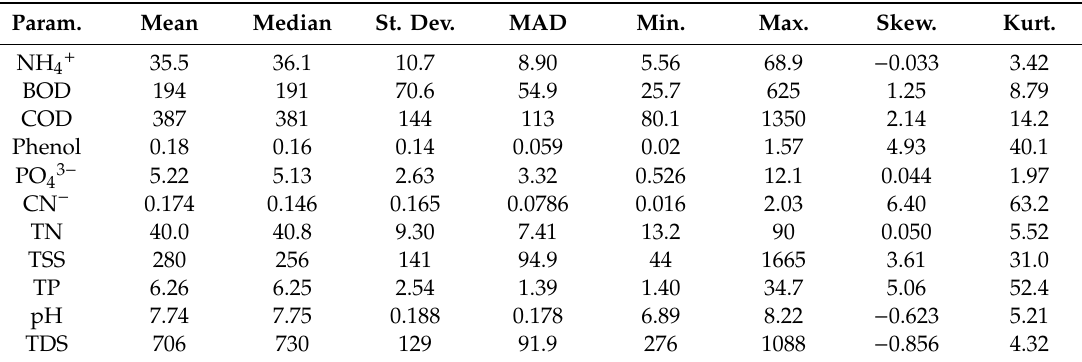
Table 1. Summary statistics of wastewater